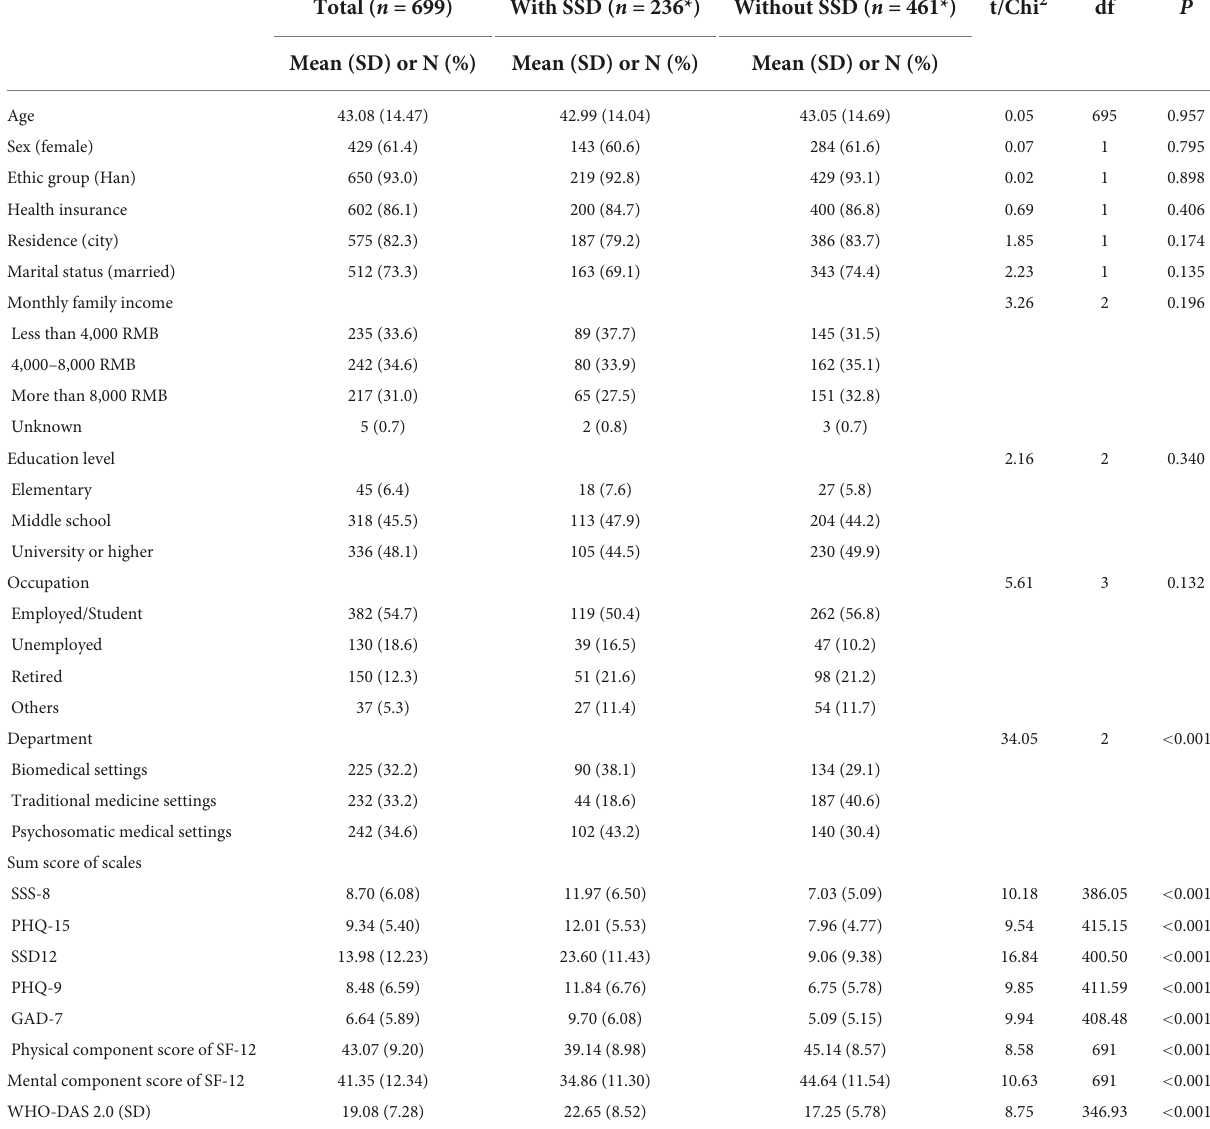
TABLE 1 Sociodemographic characteristics of outpatient sample from general hospitals in